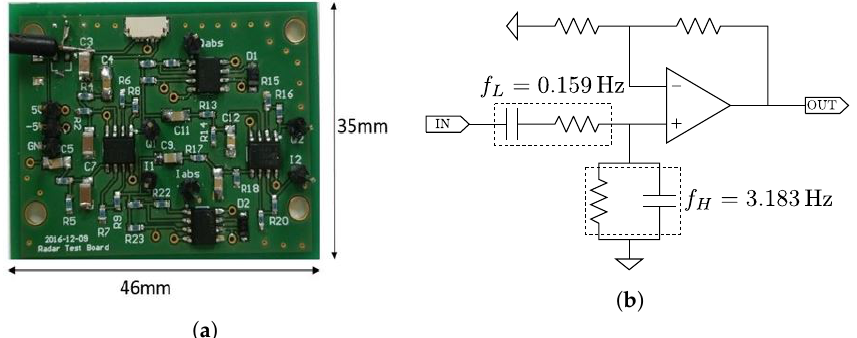
Figure 7. An ( a ) overview and ( b ) schematic of the developed